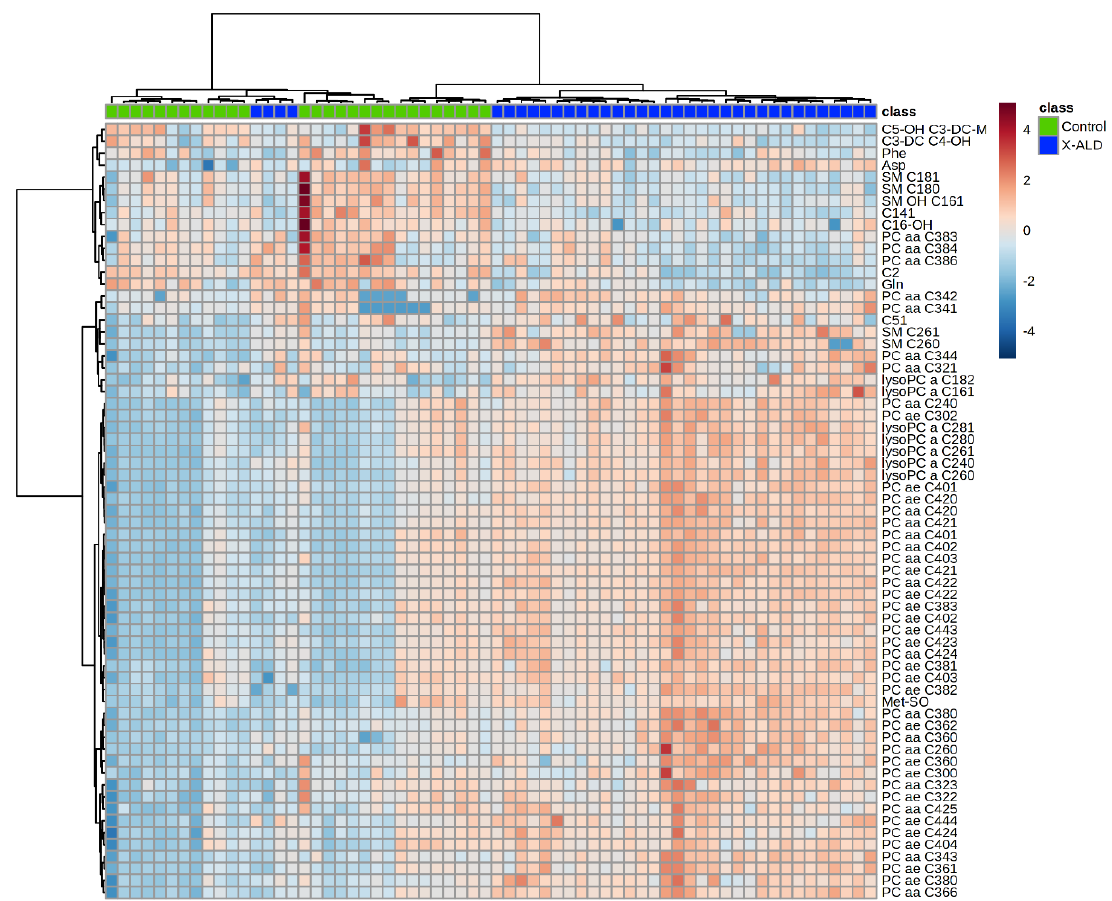
Figure A2. Heatmap illustrating clustering of X-linked adrenoleukodystrophy (X-ALD) patients and controls. Serum from patients analyzed using the Biocrates AbsoluteIDQ p180 kit. Only the 65 components with highest p -value by Student’s t -test are shown. Euclidean distance and Ward clustering were used. Normalized data was used and colormaps were auto scaled. n = 36 (X-ALD/ ABCD1 ), 28 controls. C: Acyl-Carnitine; lysoPC: lysophosphatidylcholine; PC aa: phosphatidylcholines with 2 acyl-linkages; PC ae: phosphatidylcholine with one acyl and one ether linkage; SM: sphingomyelin.